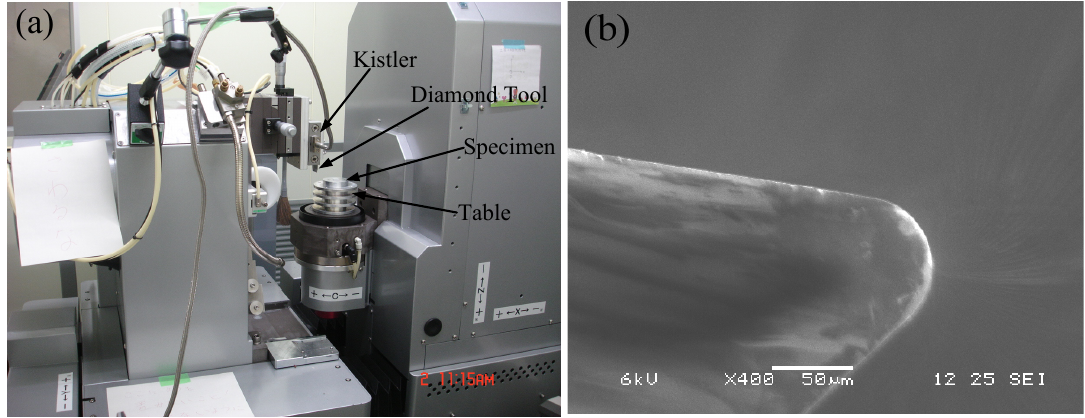
Figure 1. ( a ) Experimental setup on Ultra Nano 100; ( b ) SEM (Scanning electron microscope) morphology of the single-crystal diamond (SCD)